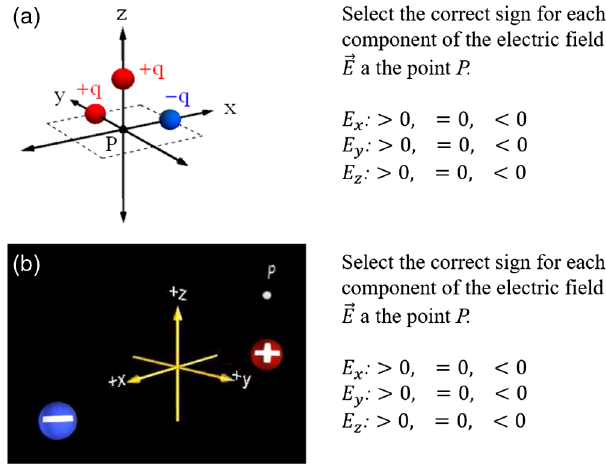
FIG. 3. Two example items from the assessment. Item (a) was posed using a 2D computer screen, whereas item (b) was posed in VR, such that students could rotate the charge arrangement and clearly see that the point P was directly above the positive